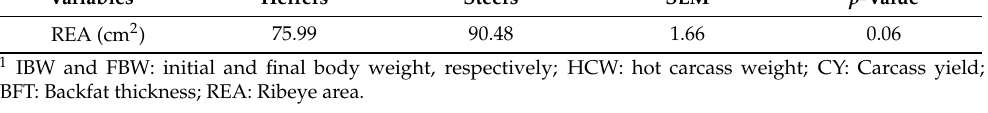
Table 2. Meat quality traits of immunocastrated F1 Montana-Nellore young steers and heifers feedlot finished.